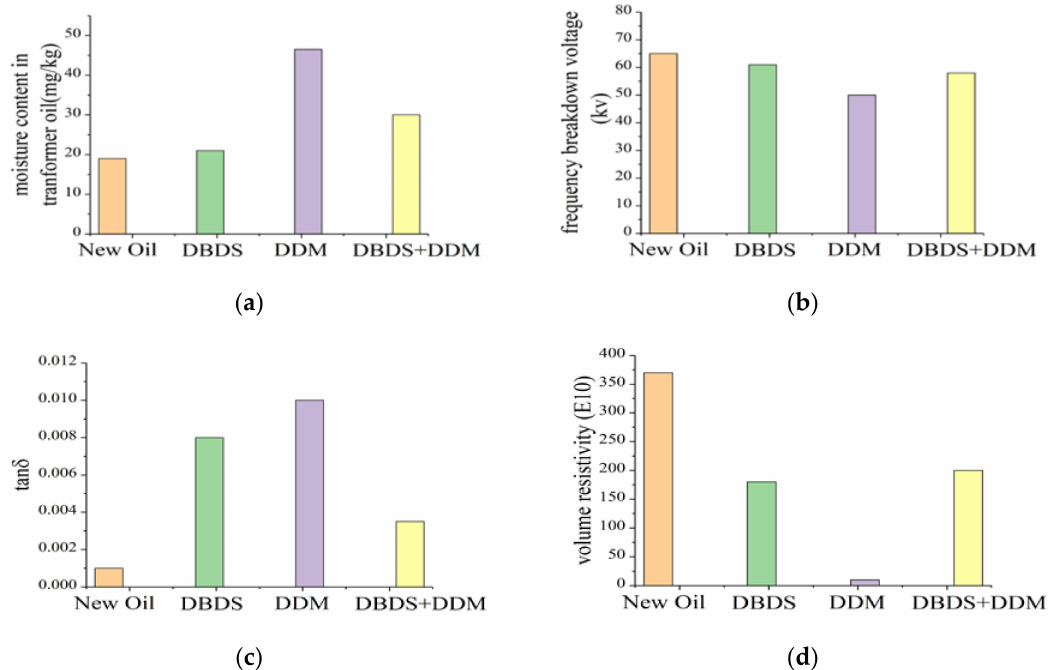
Figure 7. Effect of different sulfur components on the electrical properties of insulating oil: ( a ) Moisture in oil, ( b ) breakdown voltage at power frequency, ( c ) tan δ , and ( d ) volume